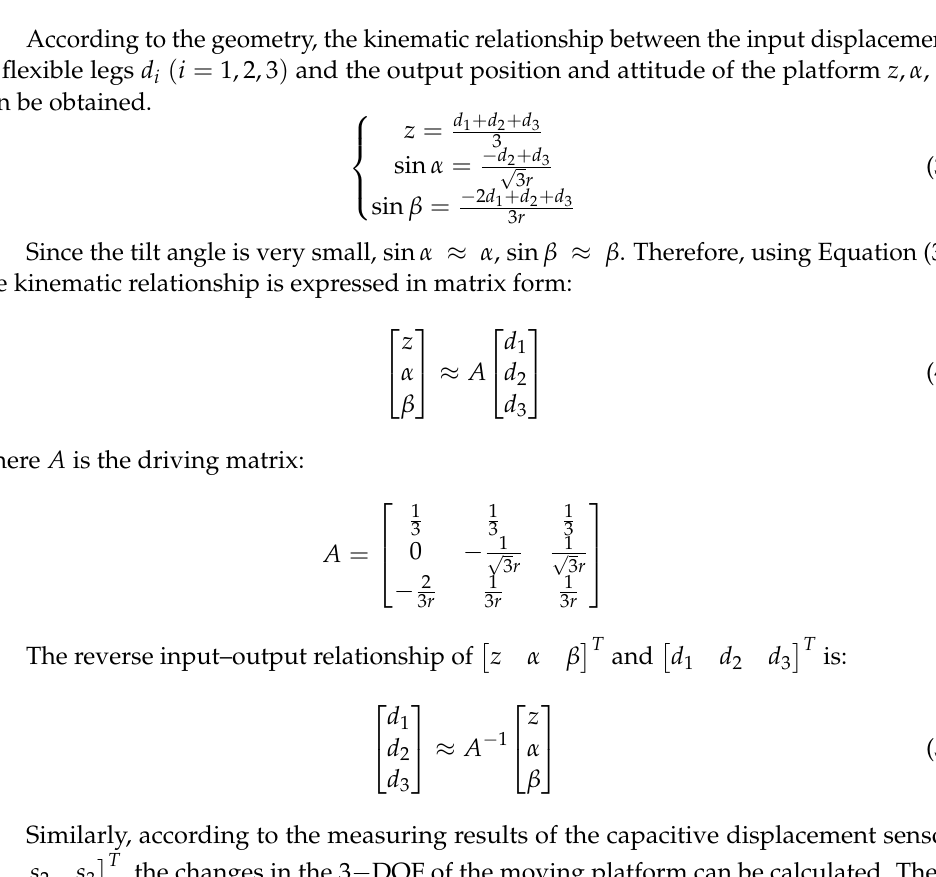
Figure 7. Geometric distribution of actuators and sensors.